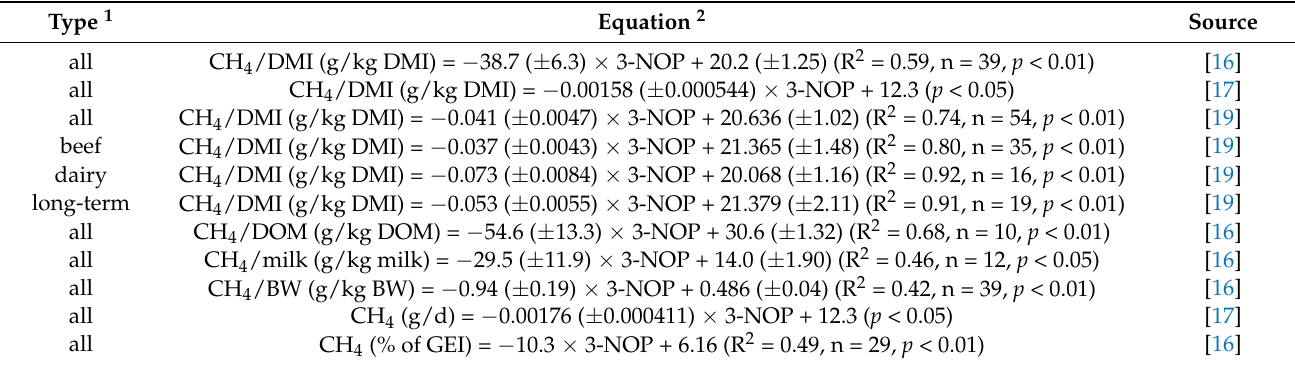
Table 1. Linear relationships between enteric CH 4 and dose of 3-NOP (g/kg DM [16], mg/kg DM [17,19]) in ruminant diets. Type